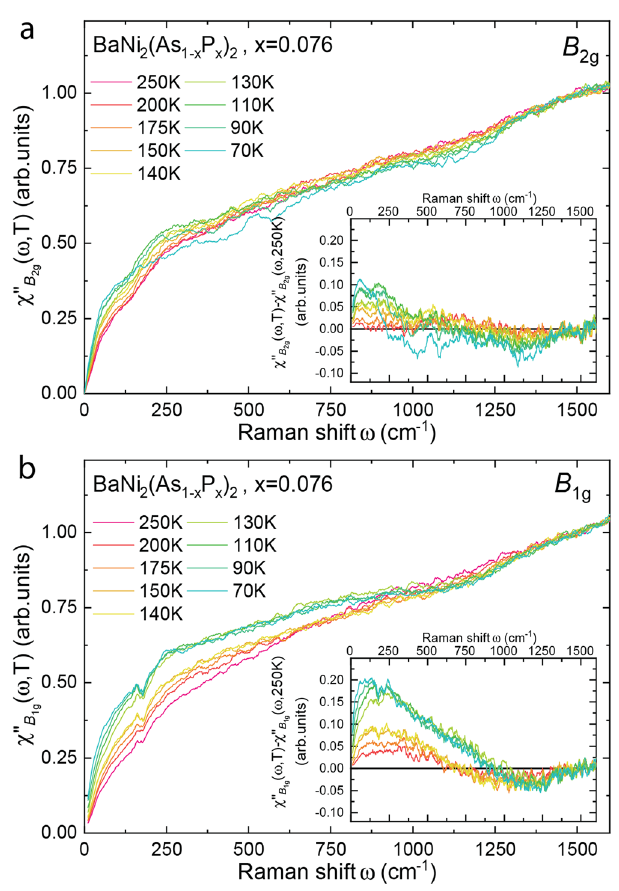
ð ω , T Þ 2g ð ω , T Þ - 2g χ 00 ω , T Þ of BaNi 2 ð As 1 (cid:2) x P x Þ 2 B 1g ð